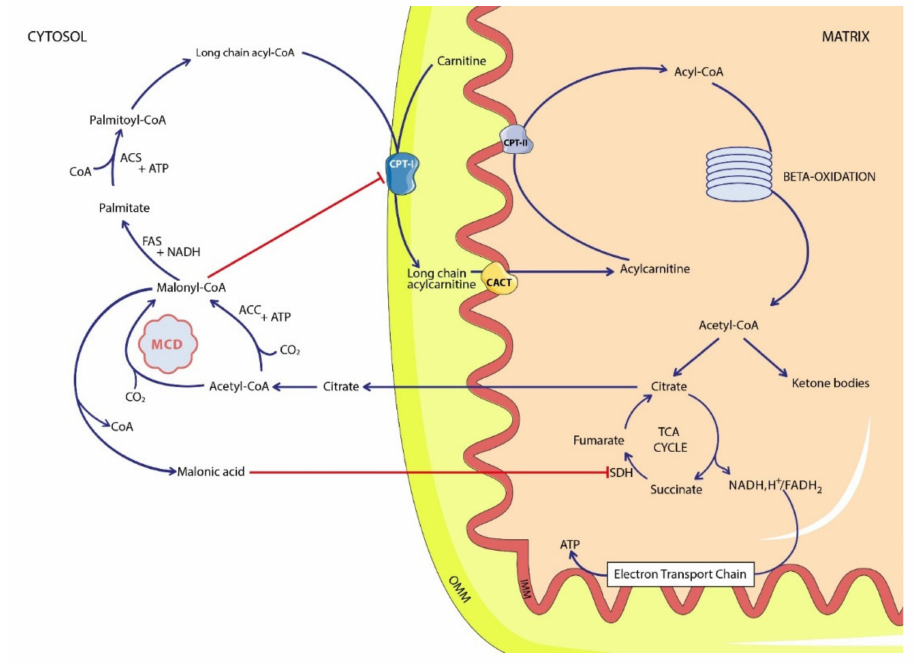
Figure 1. Simplified malonic acid pathway. ACC : acetyl-CoA carboxylase; ACS : acetyl-CoA syn- thetase; CACT : carnitine-acylcarnitine translocase; CoA : coenzyme A; CPT : carnitine-palmitoyl trans- ferase; FAS : fatty acid synthase; MCD : malonyl-CoA decarboxylase; SDH : succinate dehydrogenase; TCA cycle : tricarboxylic acid cycle; IMM : inner mitochondrial membrane; OMM : outer mitochondrial